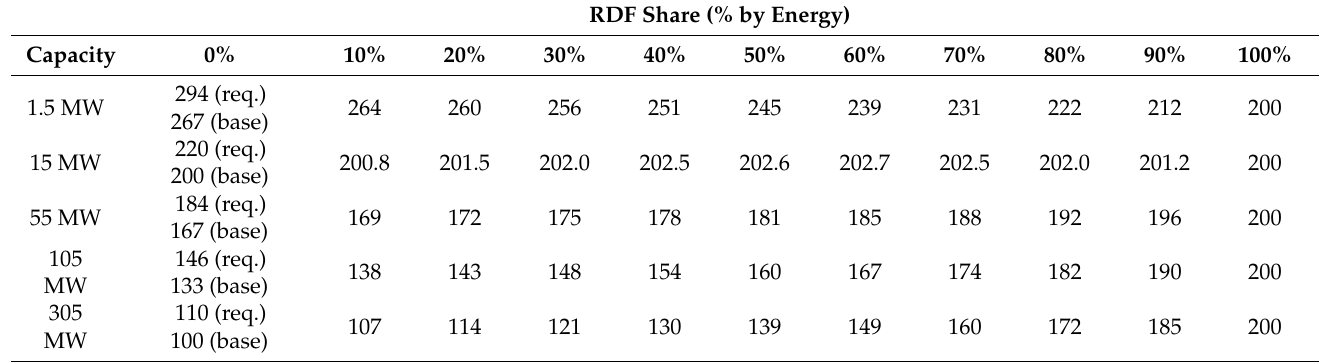
Table 5. The results of the emission standards estimation for NO x (mg/m 3 , 11% O 2 , STP), the cases of individual combustion and co-firing, RDF share 0%–100% (by energy).